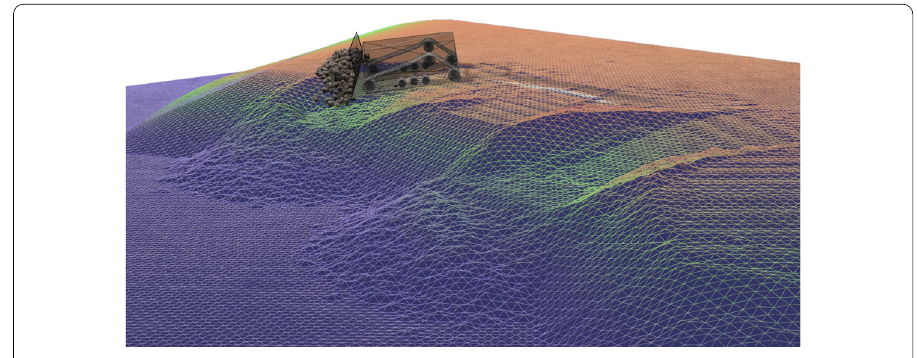
Fig. 24 Demonstration of high-precision bulldozing in a large terrain using a tracked vehicle. See the Additional file 8: Video